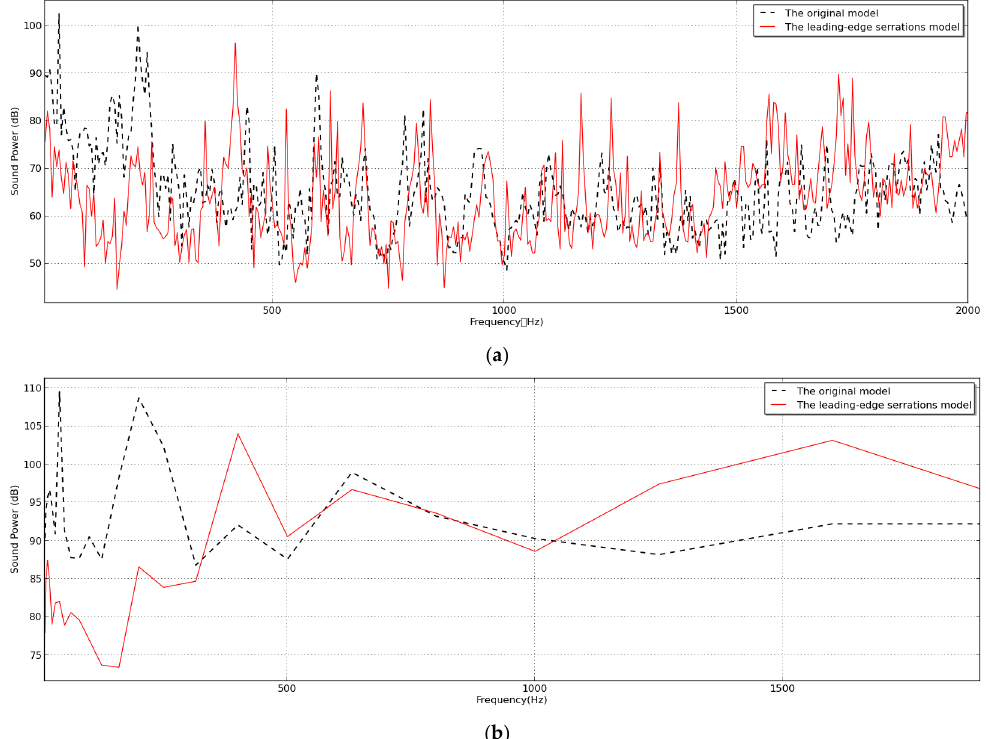
Figure 16. The sound radiation power from the two models. The red line denotes the sound radiation power from the model with leading-edge serrations. The black dotted line denotes the sound radiation power from the original model. ( a ) The narrow band; ( b ) The one-third octave band.